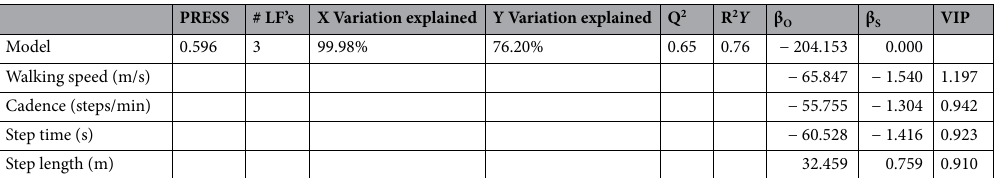
Table 4. Results of the partial least squares model for the AP MoS in HCs. AP MoS: Anterior–posterior margin of stability; PRESS: Predictive Residual Sum of Squares; # LF’s: number of Latent Factors; Q 2 : goodness of prediction; R 2 Y : goodness of fit; β O : regression coefficient for original data; β S : regression coefficient for centred and scaled data; VIP: Variable Importance in Projection; m/s: metres per second; %GC: percentage of gait